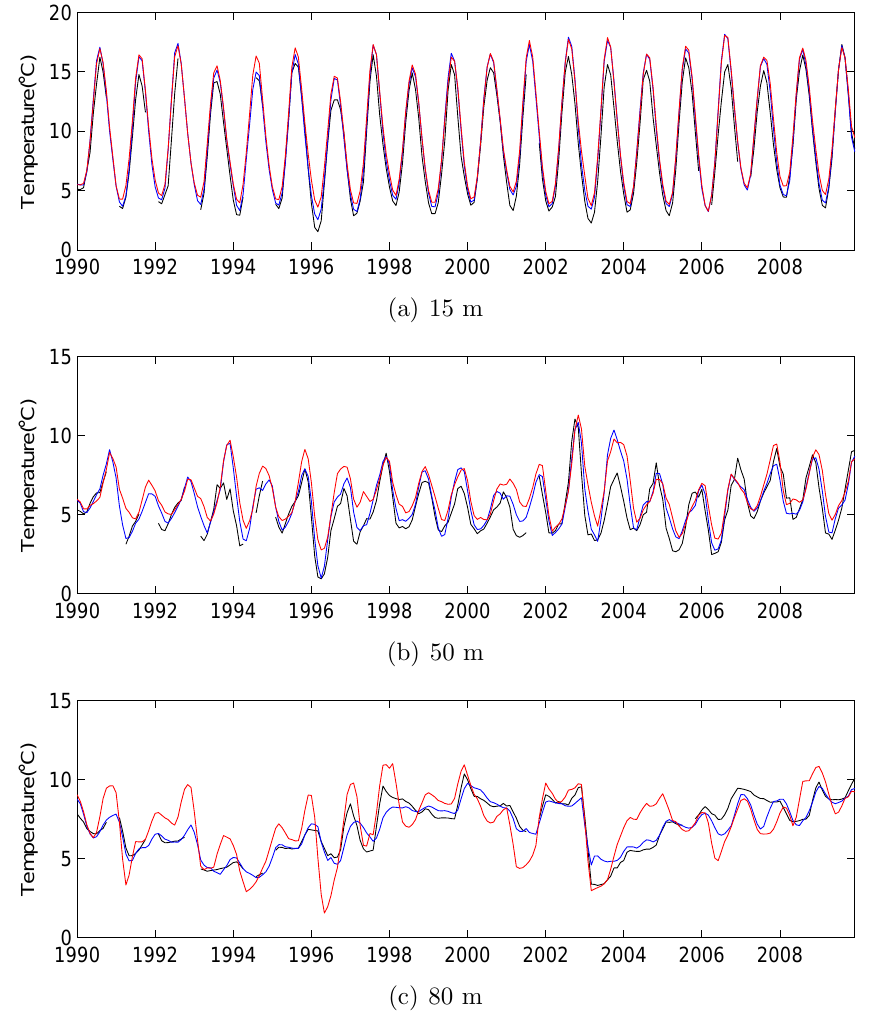
Fig. 4. The time series of temperature at 55.15 ◦ N, 15.92 ◦ E for the depth of (a) 15m, (b) 50m, and (c) 80m. The red is the free run, the blue Figure 4: The time series of temperature at (55.15 ◦ N, 15.92 ◦ E) for the depth is the reanalysis and the black is for of (a) 15 m, (b) 50 m and (c) 80 m. The red is the free run, the blue is the reanalysis and the black is for observations.